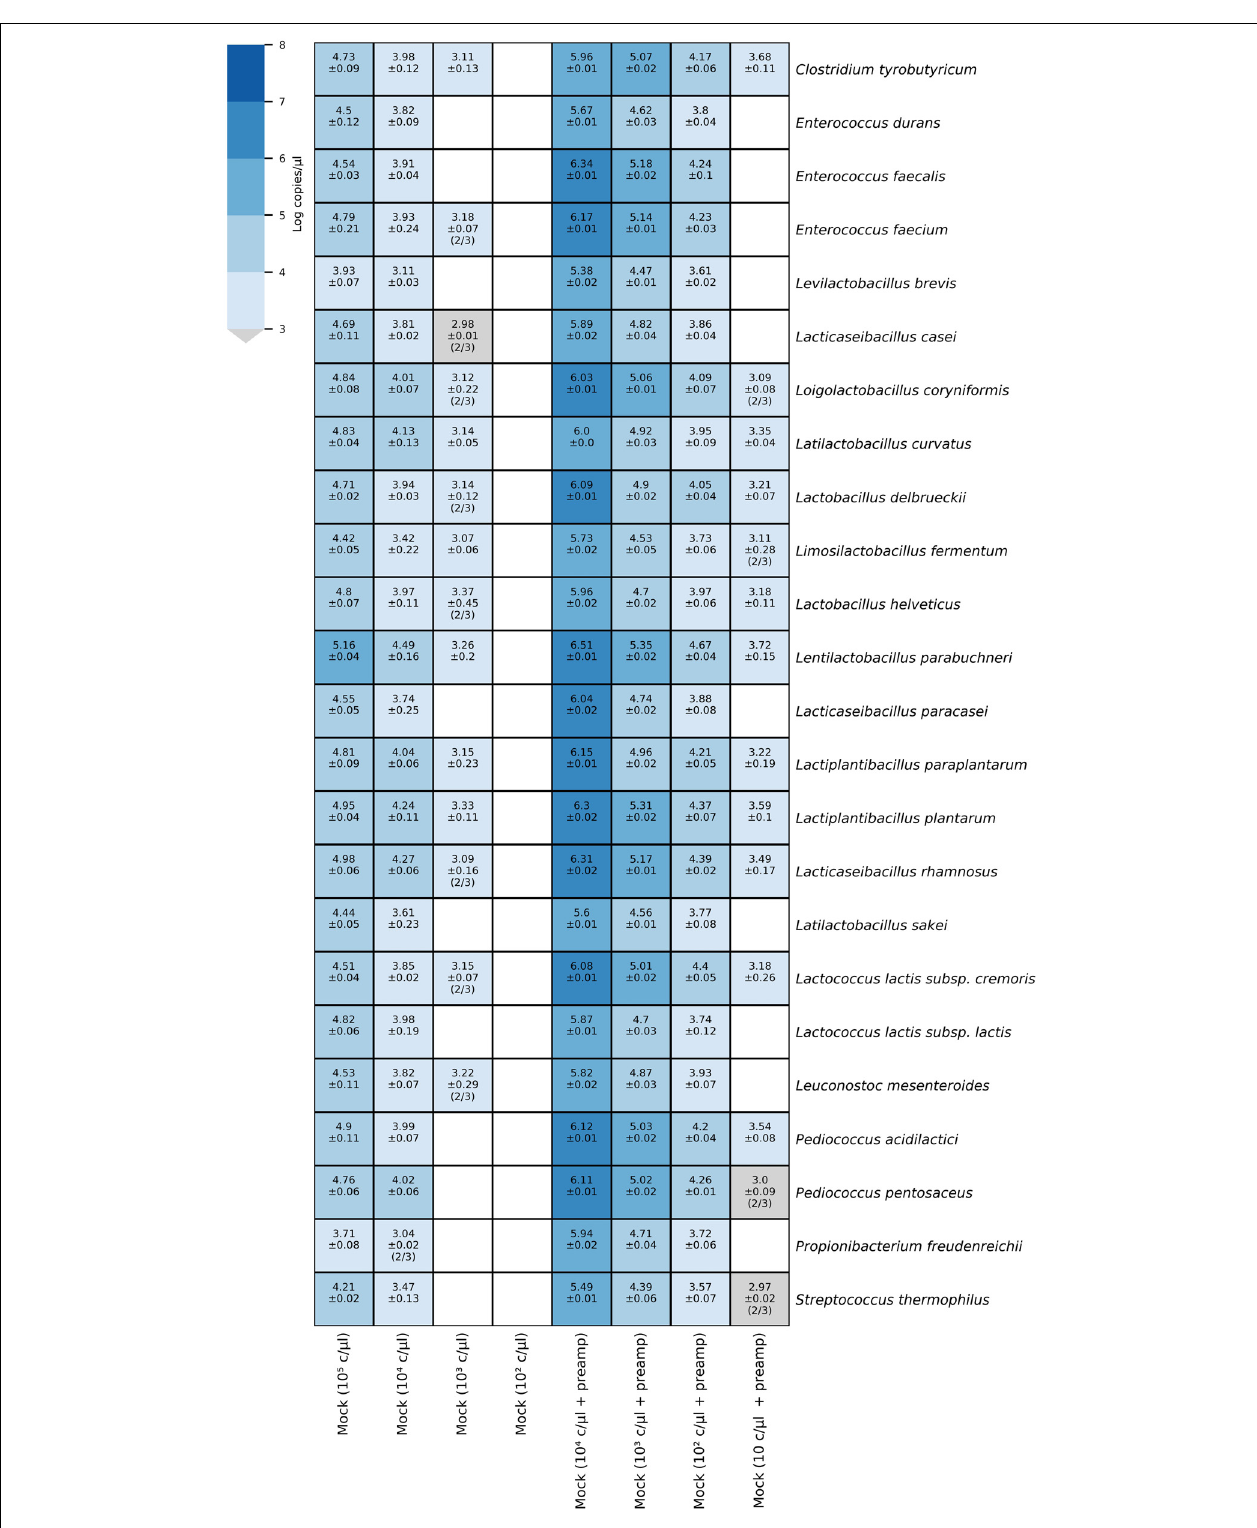
FIGURE 3 | Heatmap of microfluidic qPCR results for mock community dilutions. The heatmap annotation depicts the average logarithmic copies/ µ l and the standard deviation. When not all samples were positive, the number of positive samples out of the total number of samples (triplicates) is given in brackets. On the left side, the results correspond to the diluted mock community DNA samples quantified without preamplification whereas, the diluted mock community DNA samples depicted on the right side were pre-amplified.